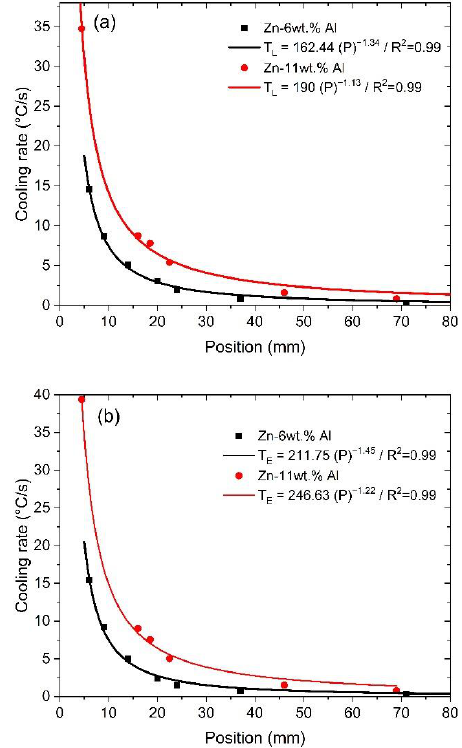
Figure 6. Cooling rates as a function of P for the Zn–6wt.% Al and Zn–11wt.% Al alloys castings: ( a ) liquidus isotherm ( Ṫ L ), and ( b ) eutectic isotherm ( Ṫ E ).